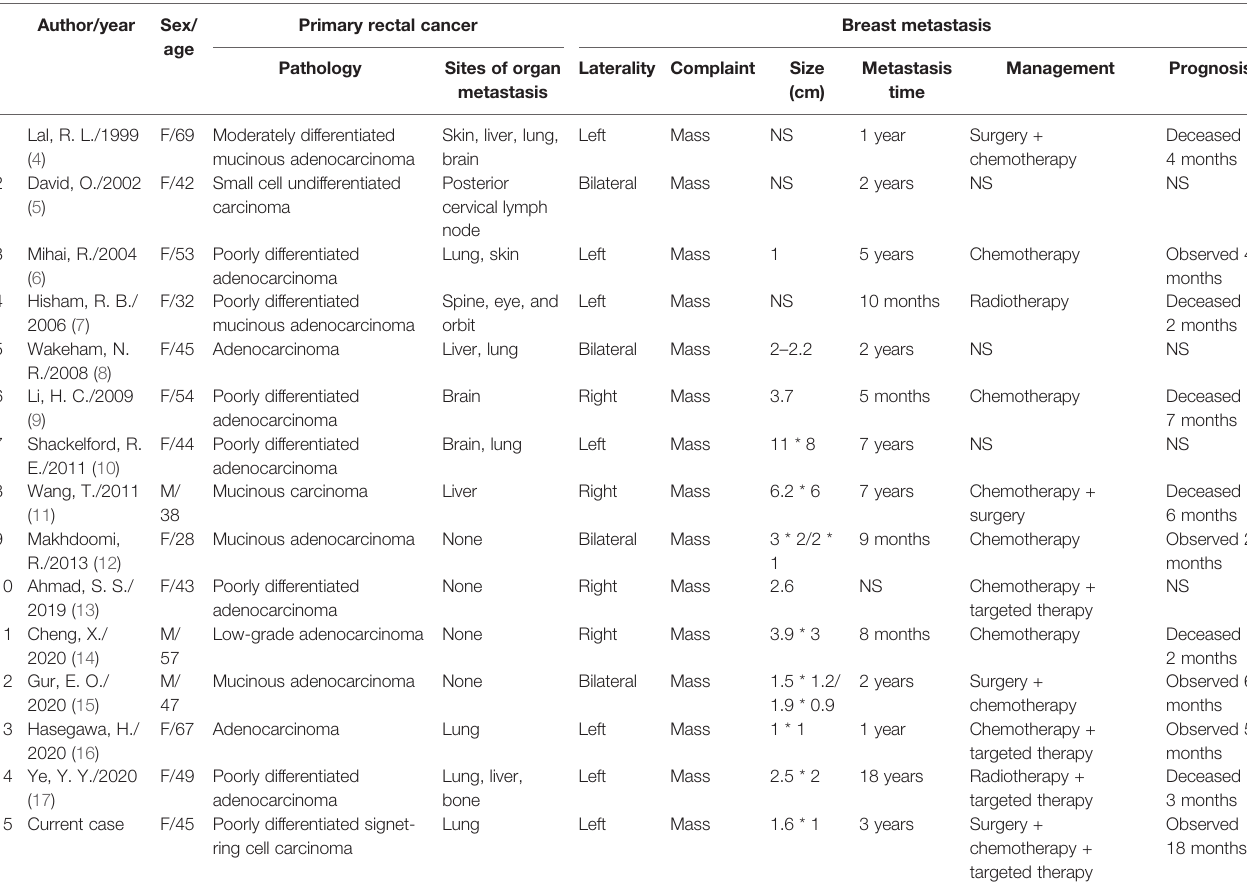
TABLE 1 | Summary of cases; breast metastases from rectal